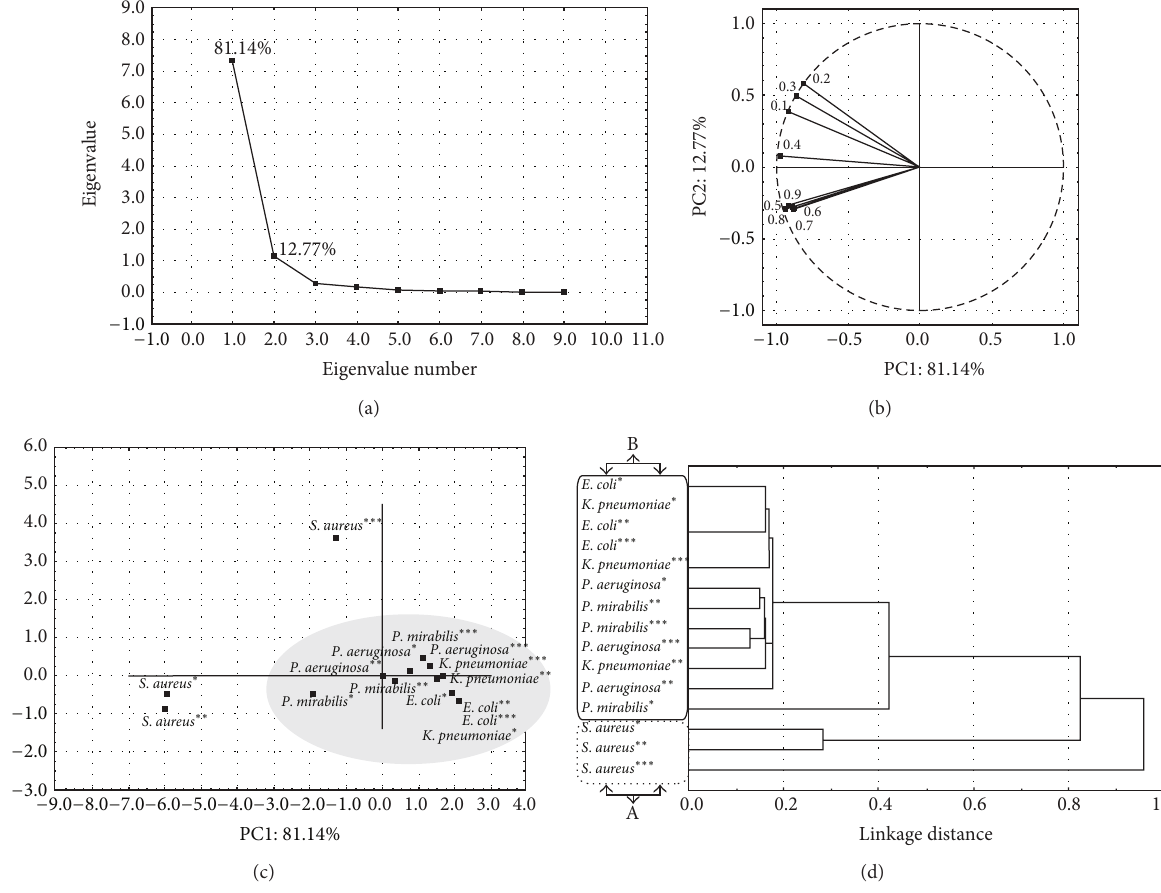
Figure 4: PCA and HCA of the antibacterial activity of the studied combinations { T. glabrescens oil-chloramphenicol ( ∗ ); geraniol- chloramphenicol ( ∗∗ ); thymol-chloramphenicol ( ∗∗∗ ) } based on their FIC values: (a) eigenvalues of the correlation matrix, (b) the loading plot of the responsible FIC values, (c) the score plot of the examined bacteria, and (d) the corresponding dendrogram. The examined FIC values are presented in Figures